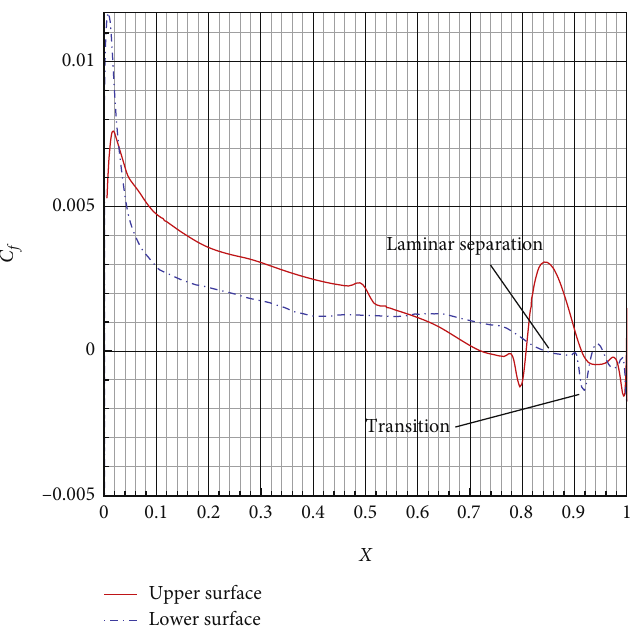
Figure 29: Skin friction distribution of Elliptic264 airfoil ( Re = 0 : 8 E 6 , α = 0 ° ).